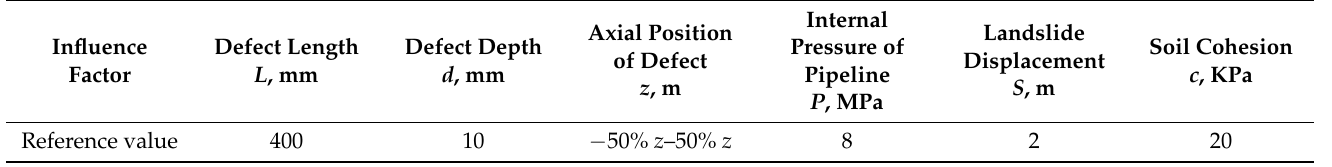
Table 7. Model parameters for varying axial position of defect.